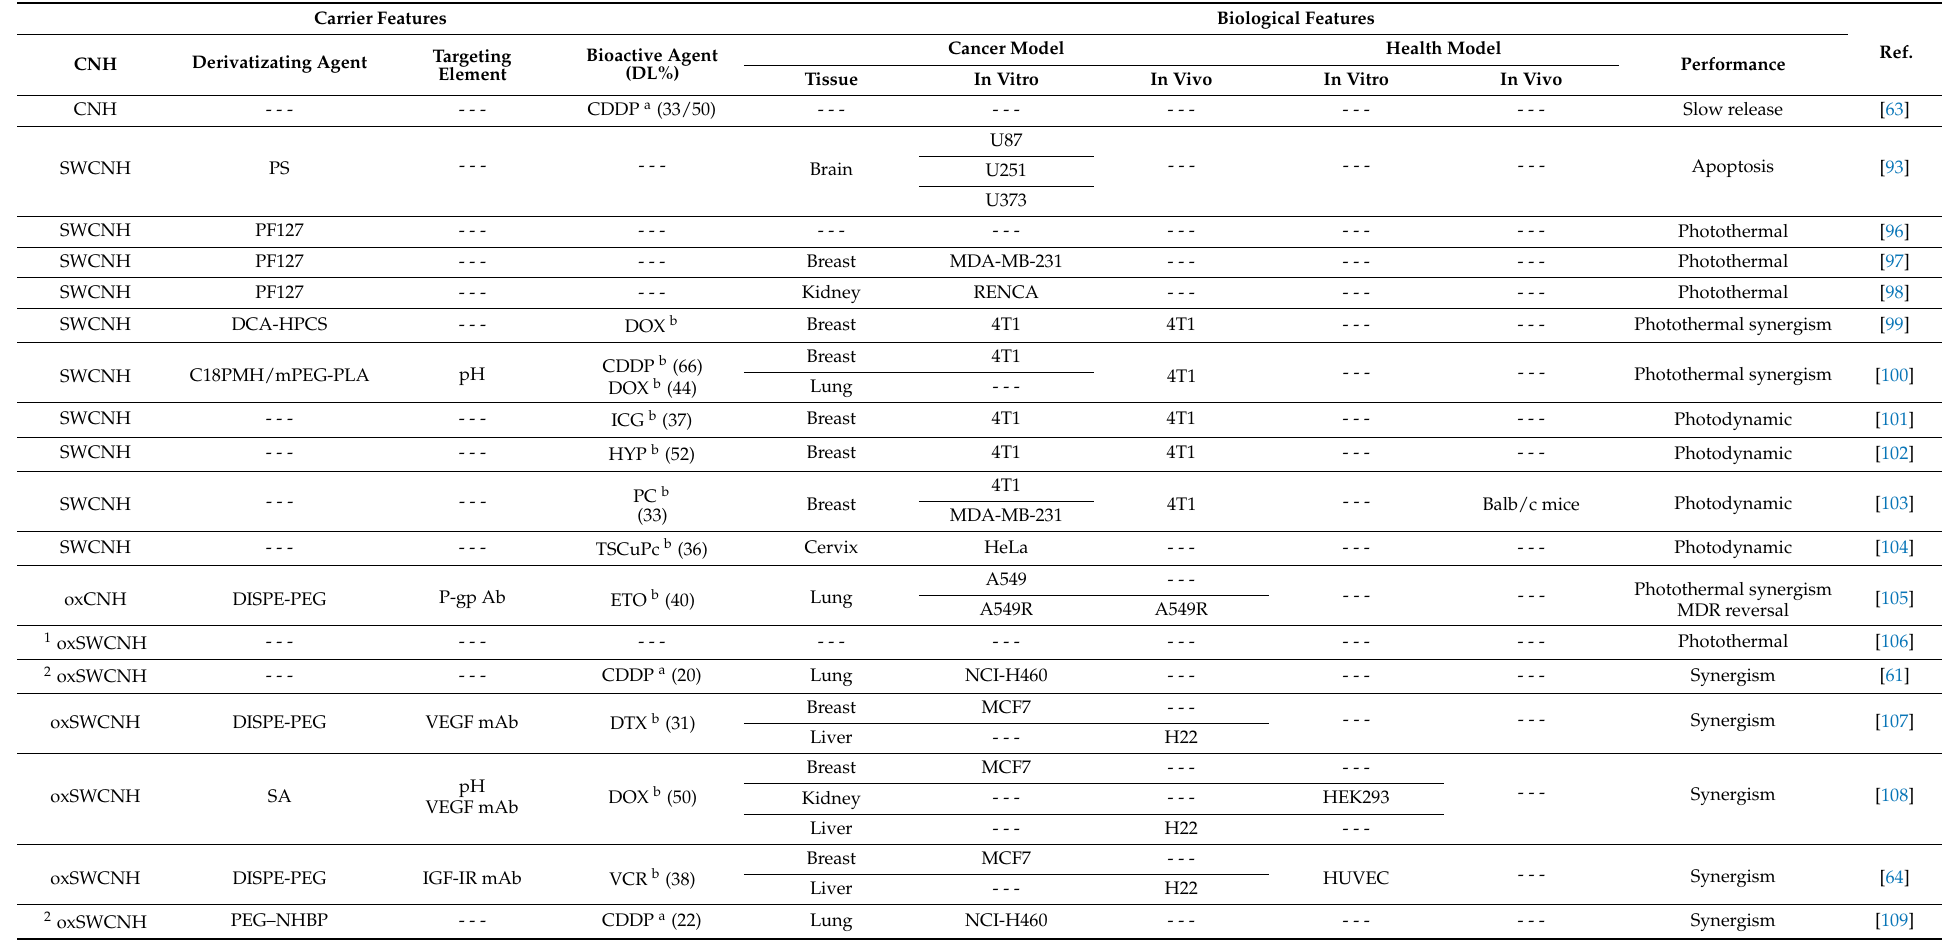
Table 1. Performance of pristine and non-covalent modified CNH for cancer